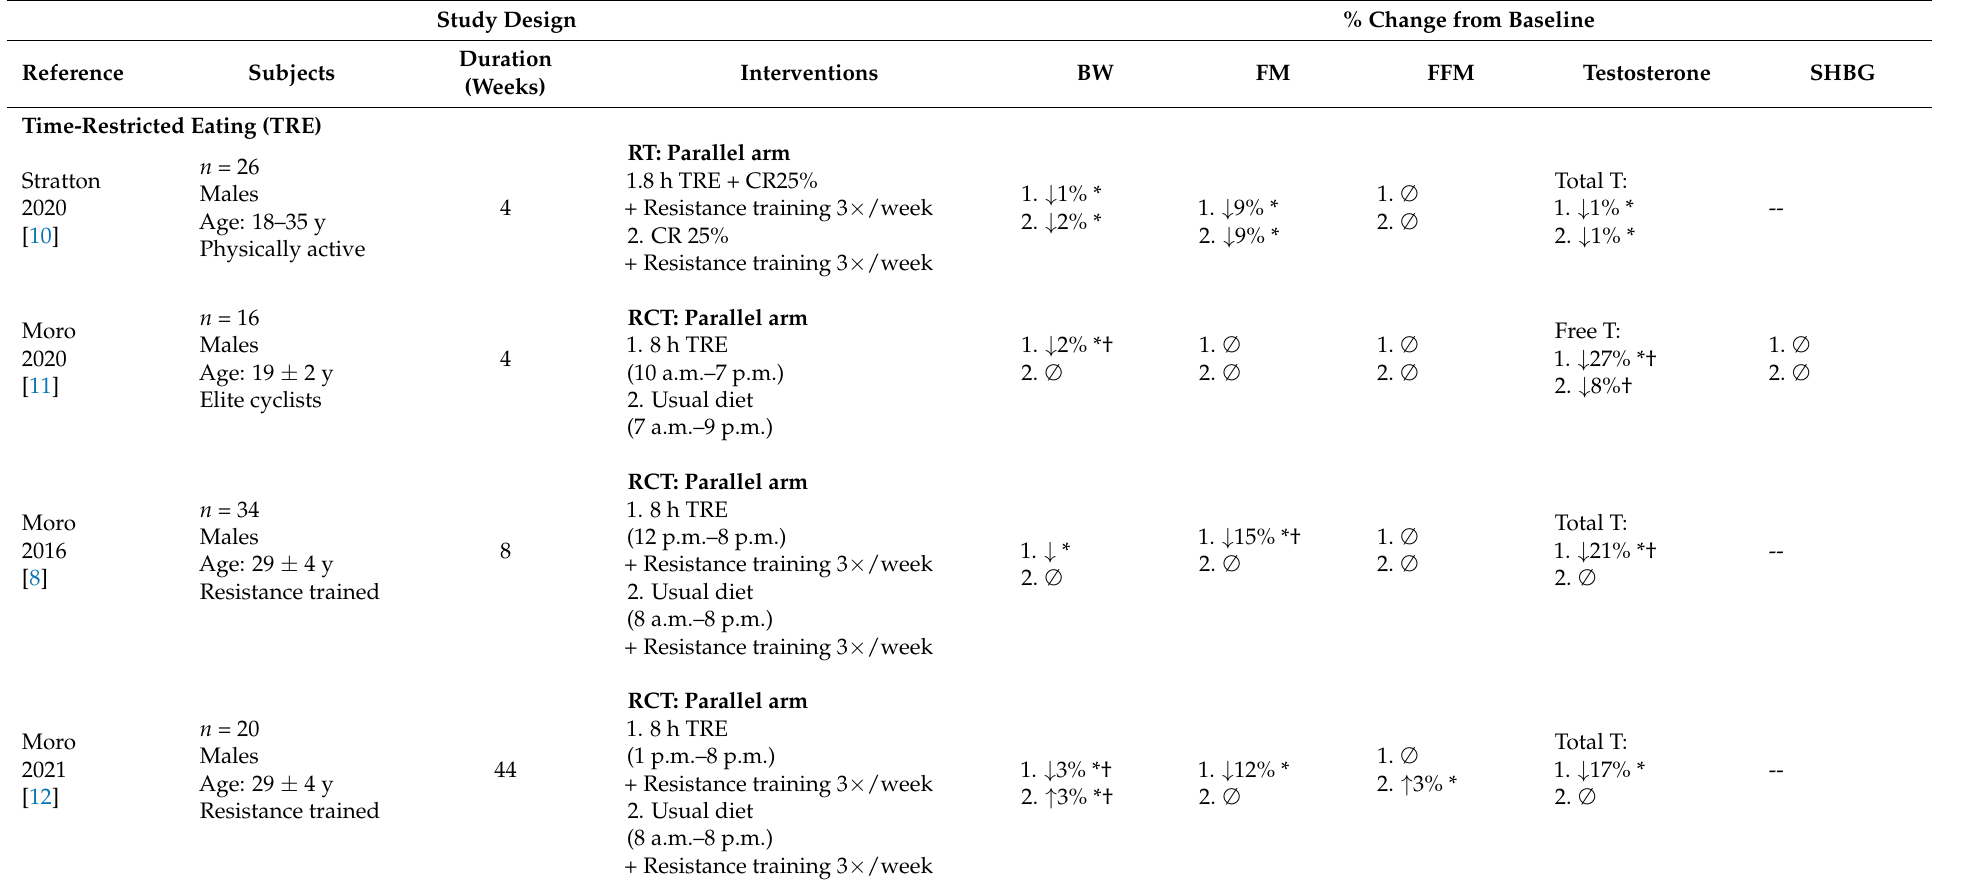
Table 2. Males: effect of intermittent fasting on reproductive hormone